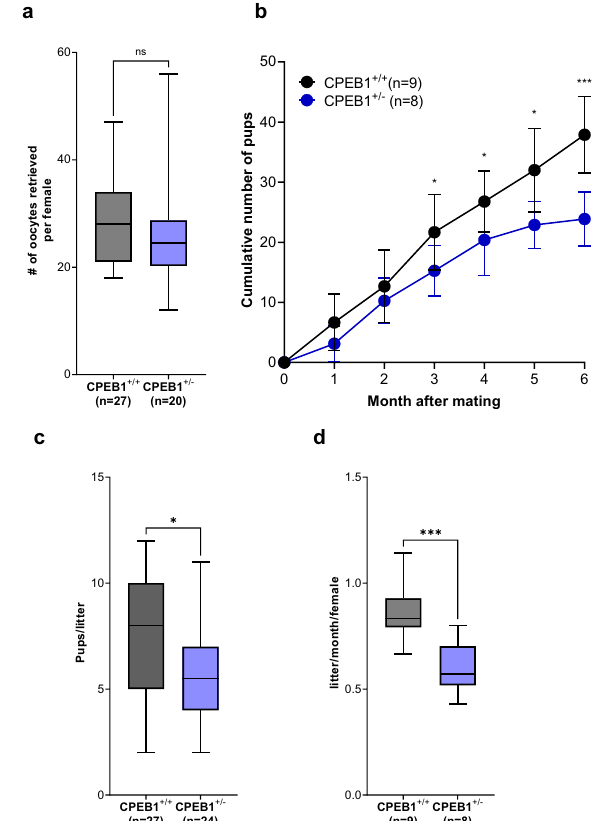
Fig.10|TheeffectofdecreasedCPEB1levelonmousefertility.a Cpeb1 +/+